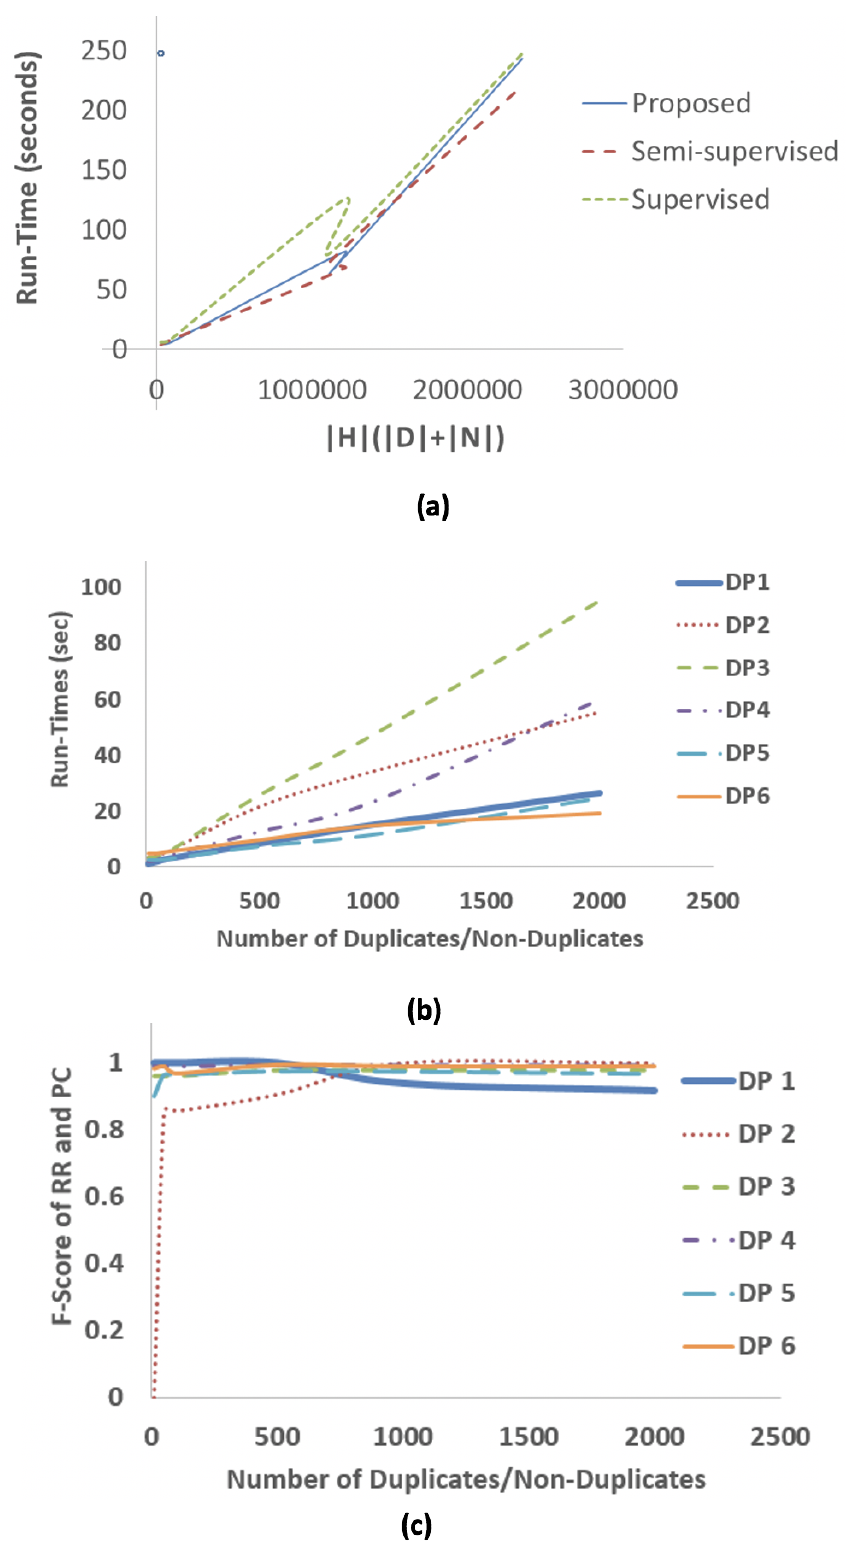
Figure 9. Experiment 4 results. ( a ) plots run-time trends of all three systems against the theoretical formula, while ( b , c ), respectively, plot run-times and f-scores of the proposed system against sample